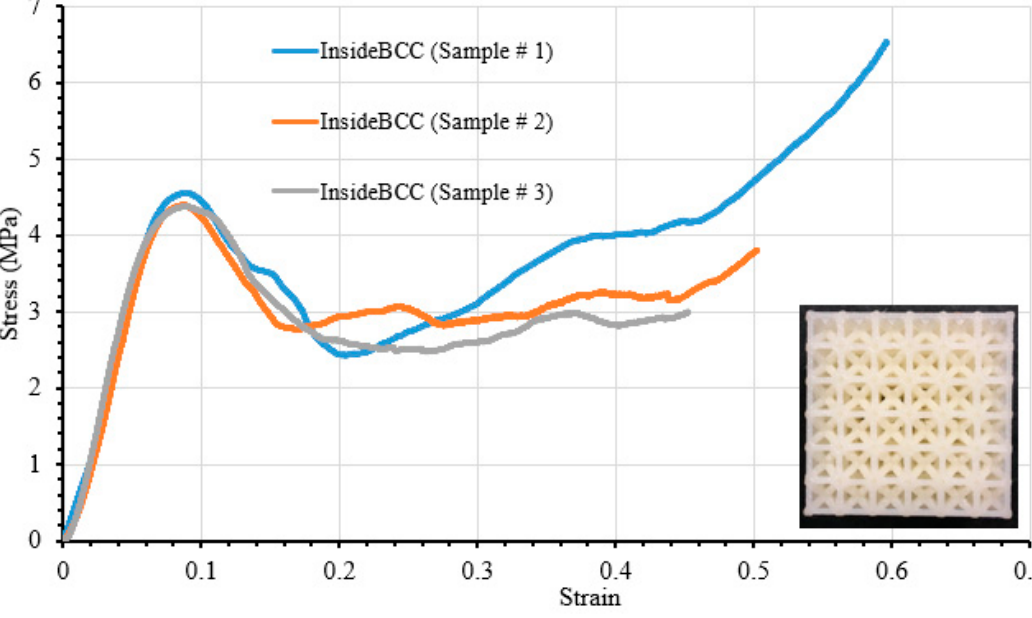
Figure 10. Stress–strain curves for three InsideBCC specimens.